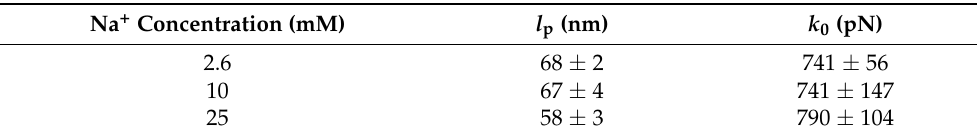
Table 5. DNA elasticity parameters for different Na + cation concentrations. Reprinted/adapted with permission from Ref. [182]. Copyright 2002,